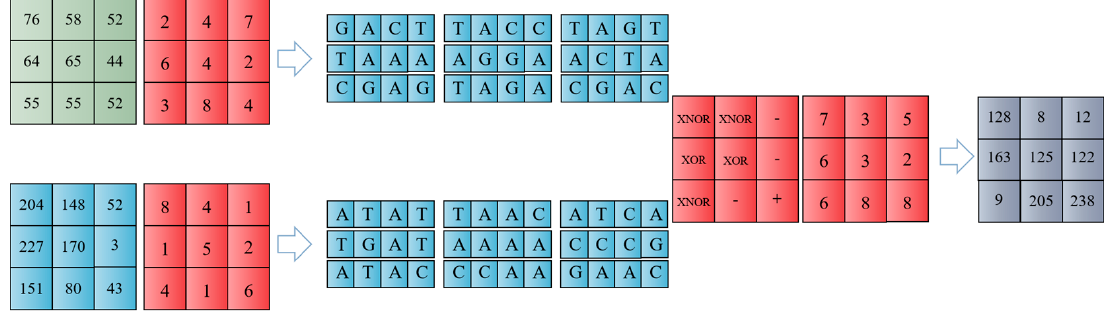
Figure 4. MRDD schematic diagram.